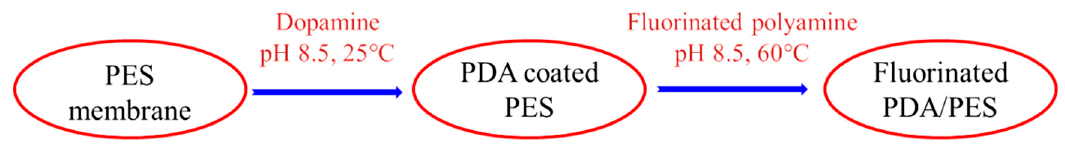
Figure 5. Schematic illustration of preparation and surface fluorination for the fluorinated PDA/PES membrane (inspired from work in [66]).